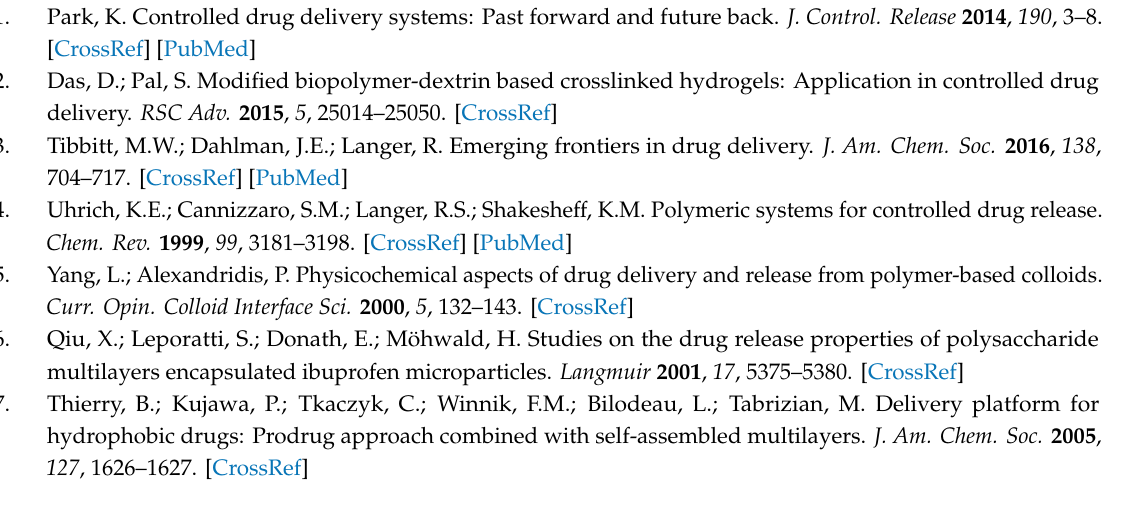
Figure S1: Stepwise frequency decrement of CHI / HA, CHI / ALG, and CHI / TA films as a number of layers measured by QCM, Figure S2: Multilayer films thickness growth with regression line as number of bilayers increased, Figure S3: SEM images of CHI / TA film. (A) Bare CHI / TA film and (B) dipping in PBS bu ff er at 37 ◦ C for 48 h, Figure S4: All release profiles of (A) FITC, (B) Ova, and (C) DOX, respectively, Figure S5: The cell viability of human dermal fibroblast cell, Figure S6: Confocal microscope image of DOX-incorporated multilayer films, Table S1: Table for degradation rate of multilayer films under 1 × PBS at 37 ◦ C measured by changes in